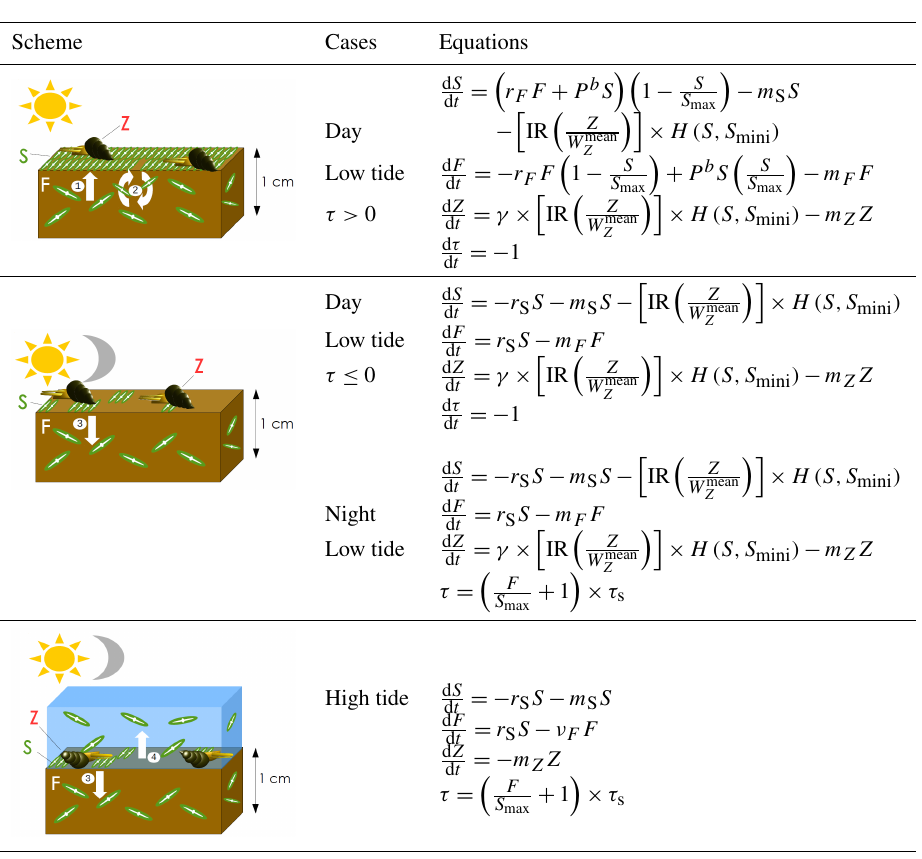
Table 1. Conceptual schemes and differential equations of the biological model, including the MPB biomass within the sediment first centimetre ( F ), the MPB biomass within the biofilm ( S ), and the biomass of P. ulvae ( Z ). The upper case corresponds to daytime emersion periods when MPB cells migrate at the sediment surface ( (cid:192) ) to produce and transfer biomass to the sediment first centimetre ( (cid:193) ). The middle case corresponds to the day or night-time emersion period when MPB cells migrate down to the sediment first centimetre ( (cid:194) ). The lower case corresponds to immersion periods when MPB cells are chronically resuspended from the first centimetre to the water column ( (cid:195) ) and the remaining MPB cells within the biofilm finish their downward migration ( (cid:194) ). P. ulvae grazing is only active during emersion periods (upside down in immersion scheme) (modified from Guarini et al., 2008).